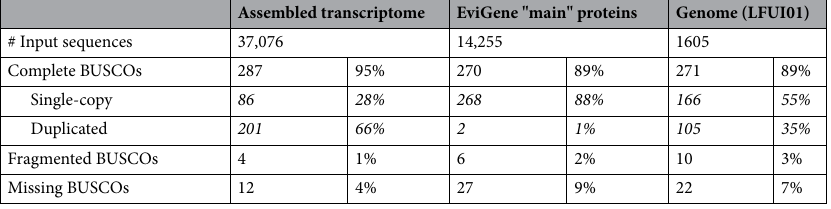
Table 2. BUSCO quality and completeness assessment of the B. mandrillaris EviGene transcript assembly and predicted proteome compared to the draft genome (reference dataset for eukaryotes: N = 303). Italic values describe Complete BUSCOs (single-copy +